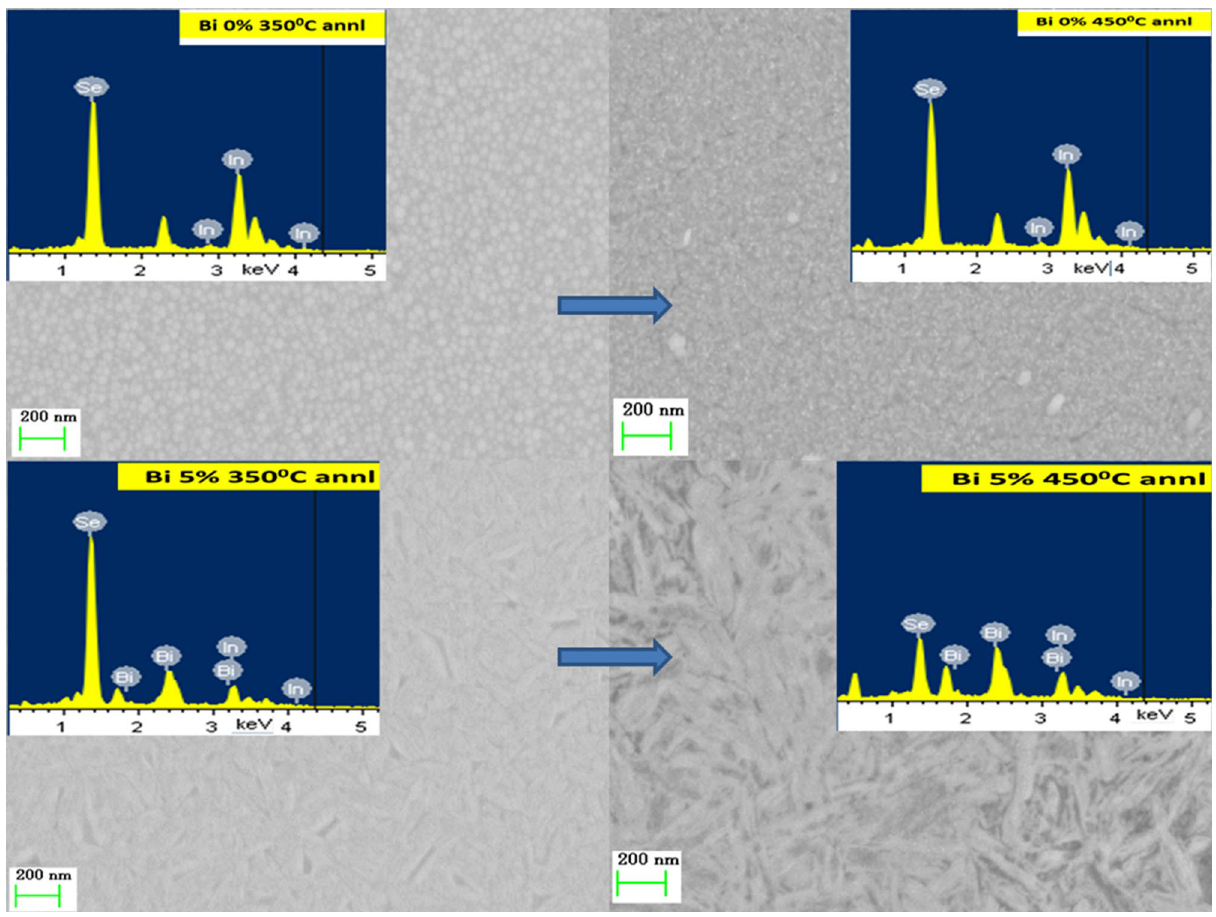
Figure 2. FESEM images of 350 °C and 450 °C annealed In 35 Se 65 and Bi 5 In 30 Se 65 thin